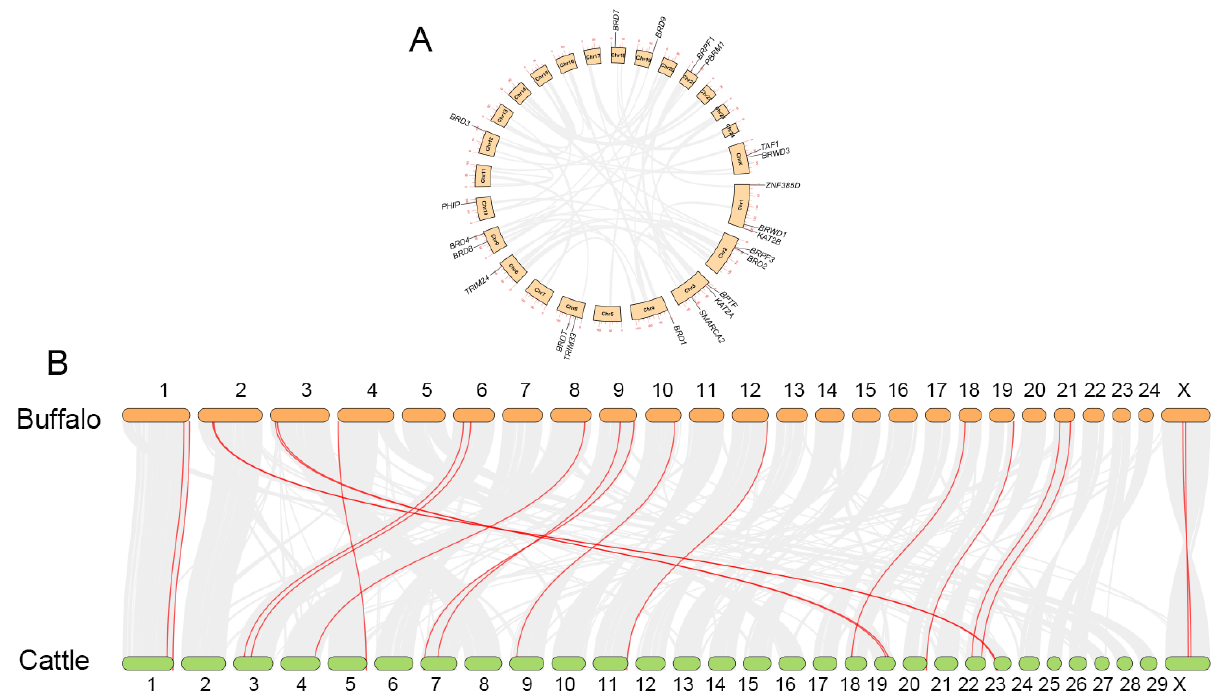
Figure 5. Gene duplication of buffalo genome ( A ) and collinear analysis of buffalo and cattle genome ( B ). Collinear genes are linked by gray lines, and collinear BRD genes are linked by red lines.